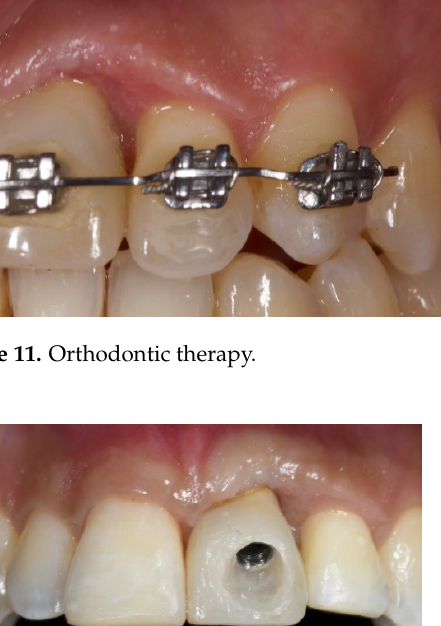
Figure 11. Orthodontic therapy.